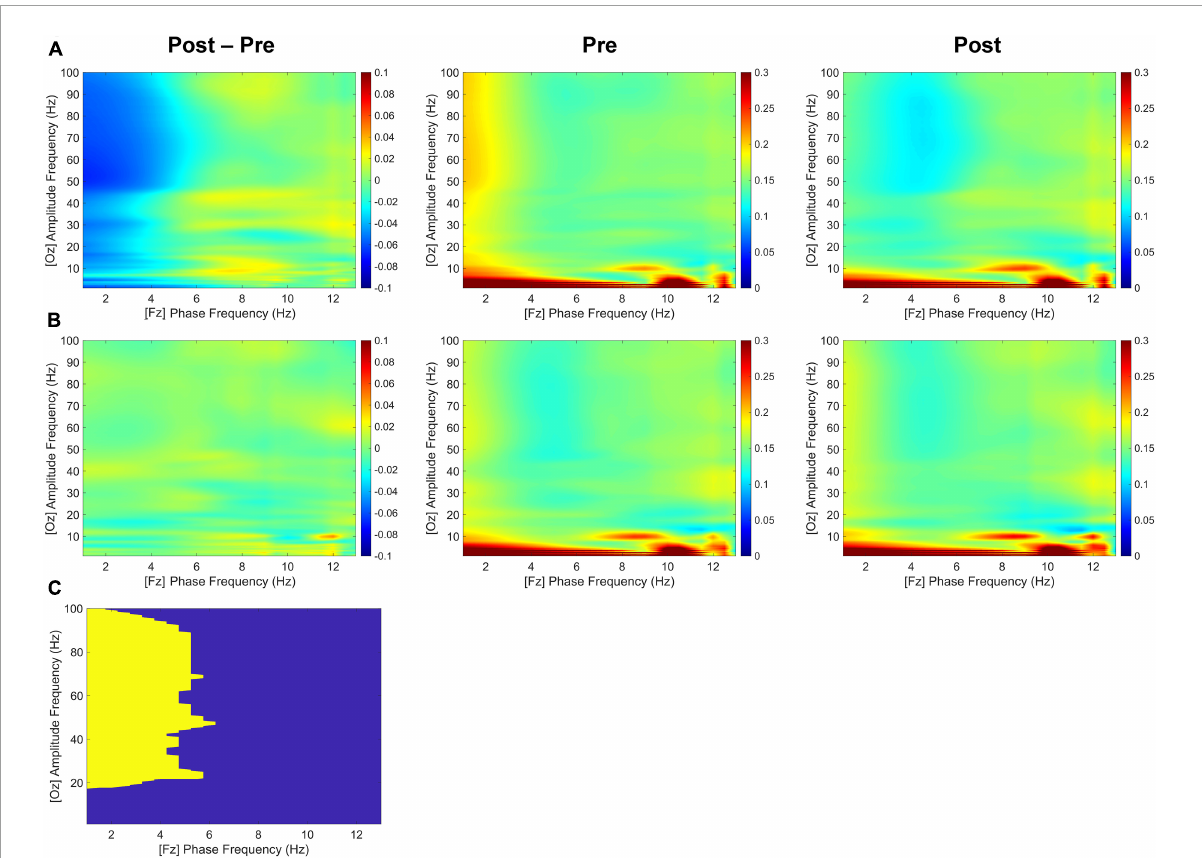
FIGURE5 Transcranial alternating current stimulation (tACS)-mediated cross-frequency phase-amplitude couplings. The grand-averaged differences in phase-amplitude couplings between pre- and post-treatment (post-treatment minus pre-treatment) as a function of analytic amplitude (1 − 100 Hz) and analytic phase (1 − 13 Hz) for the Fz-phase/Oz-amplitude combination during the second half ( − 1,000 to 0 ms before the test-stimulus presentation) of the retention periods in both (A) the tACS-treated and (B) the sham groups. Their pre- and post-treatment conditions are also individually displayed. (C) The statistically significant regions are highlighted in yellow [one-sided permutation test with independent (unpaired) samples, p < 0.05 cluster defining threshold; p < 0.05 cluster threshold]. The color bar indicates differences in coherence between pre- and